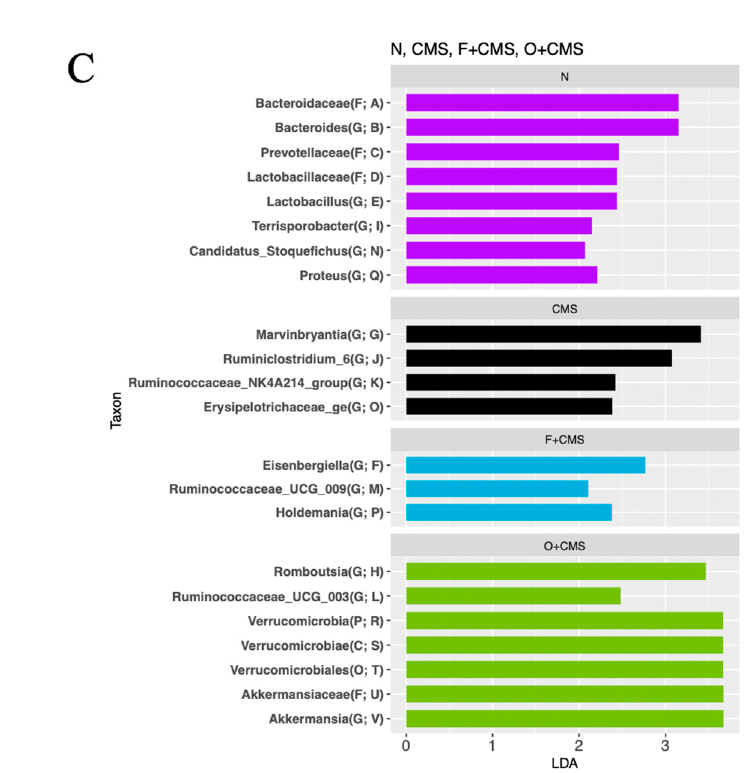
Figure 5. Taxonomic differences in faecal microbiota. Comparison of relative abundance across all groups. ( A ) Non-metric multidimensional scaling Bray distance methods were used to discriminate between the five groups. ( B ) LEfSe was used to identify the most differentially abundant bacteria in all groups, except the CMS+P group. The brightness of each dot is proportional to the effect size. ( C ) Only bacteria meeting a linear discriminant analysis threshold of >2 are shown (n = 5 per group).